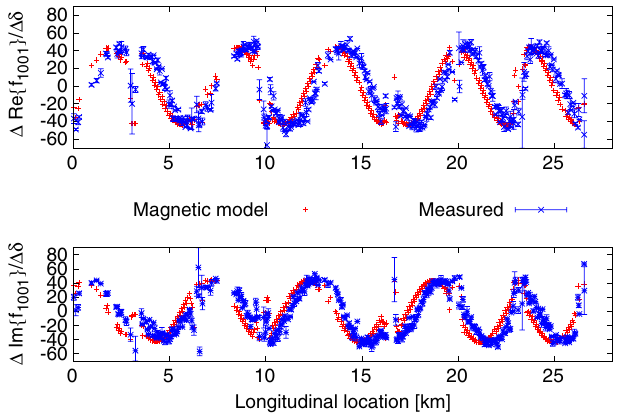
FIG. 3. Comparison between the measured chromatic coupling (blue) and the expected chromatic coupling from our magnetic model (red). This is for beam 2 at 4 TeV, with a (cid:1) (cid:10) of 60 cm.